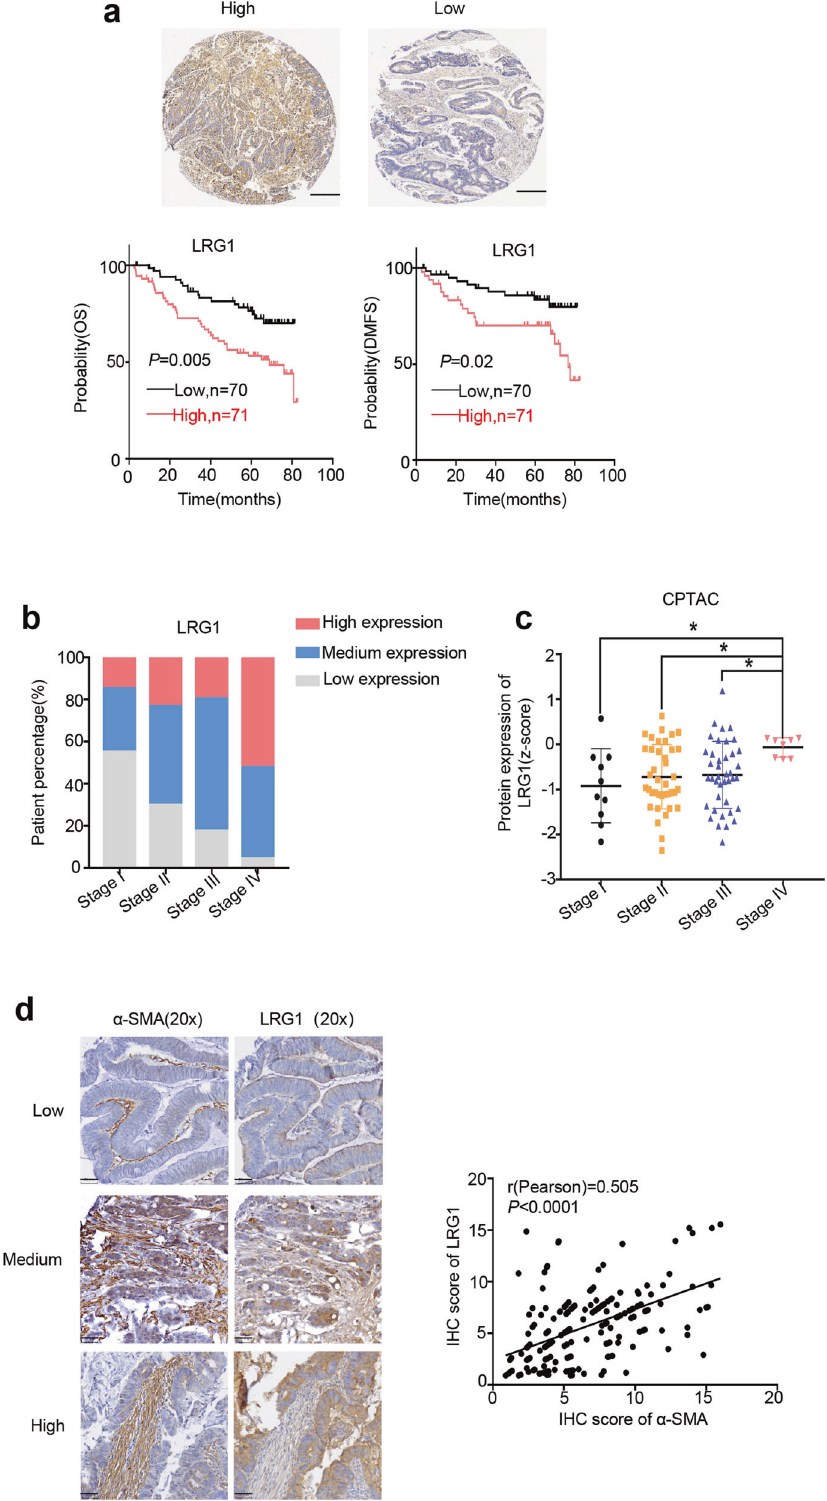
Fig. 6 CAFs-associated high expression of LRG1 predicts poor clinical outcome in CRC. a Up: Representative IHC staining of LRG1 in TMA (Scale bar, 100 μ m). Down: Kaplan – Meier analysis of the association of overall survival (OS) or distant metastasis free survival (DMFS) with LRG1 protein level in 141 CRC patients from TMA. b Graph showing the percentage of patients with different level of LRG1 in four different stages in 141 CRC patients from TMA. I-IV represent stages of patients according to AJCC TNM staging system. ( n = 20, stage I; n = 47, stage II; n = 51, stage III; n = 23, stage IV). c Graph showing LRG1 protein level in different TNM stages using data from CPTAC. d Left: Representative IHC staining of LRG1 and α -SMA in TMA (Scale bar, 50 μ m). Right: Plot showing correlation between α -SMA and LRG1 protein level in patients from TMA ( n = 190). Error bars represent SD; n = 3. * P < 0.01.